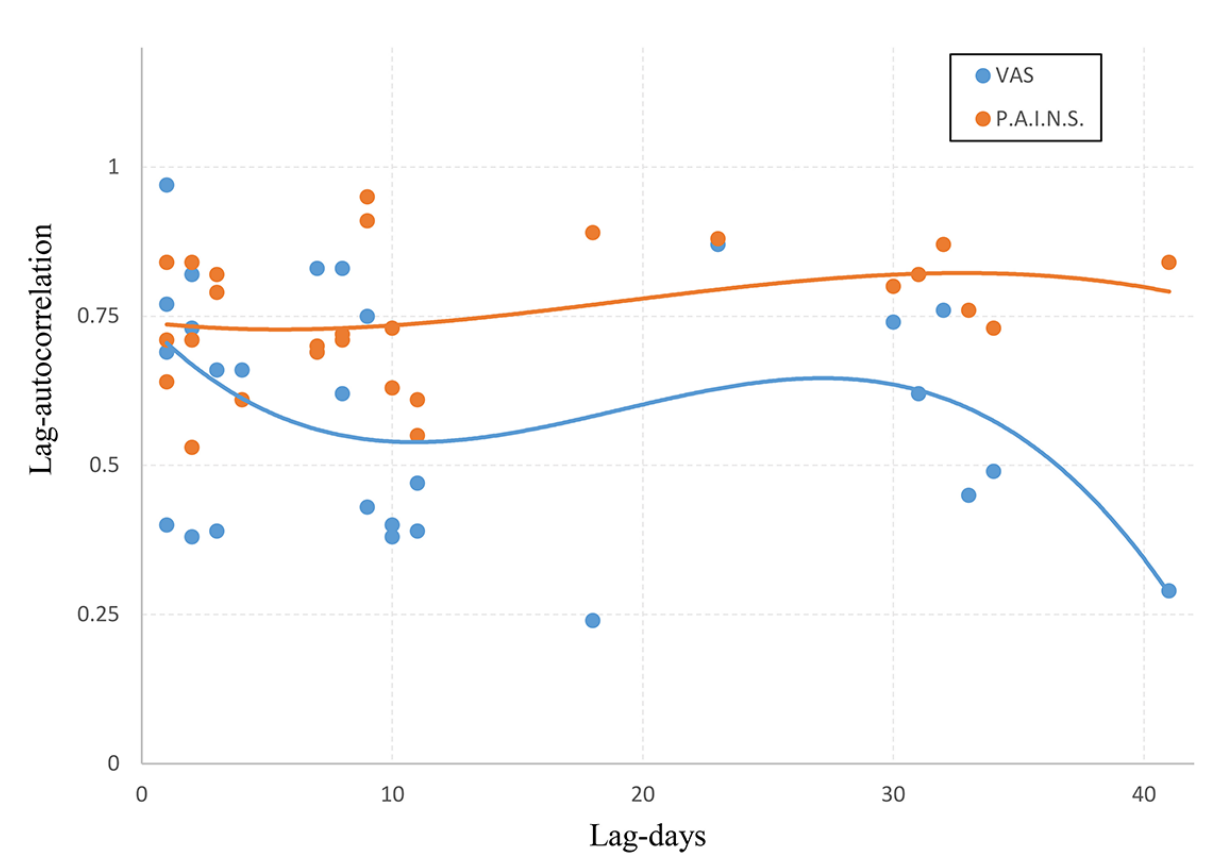
Figure 5. Correlation over time between PAINS and VAS scores. The short-term 1-day reliability for PAINS (red) and VAS (blue) scores were similar. However, longer term reliability is consistently high for PAINS and higher than that for VAS on average. PAINS: pain area and intensity number summation; VAS: visual analog